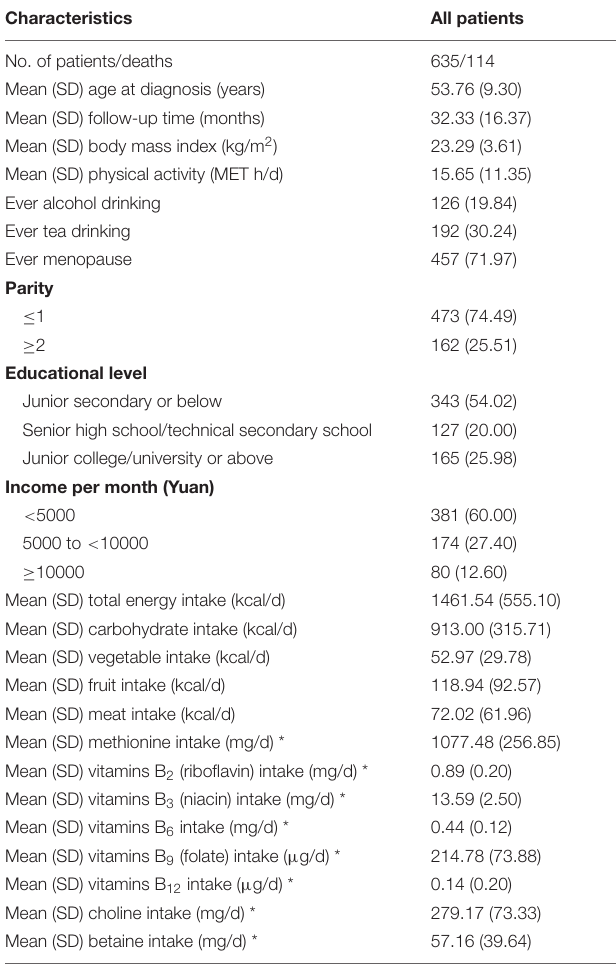
TABLE 1 | Baseline characteristics of ovarian cancer patients ( n =